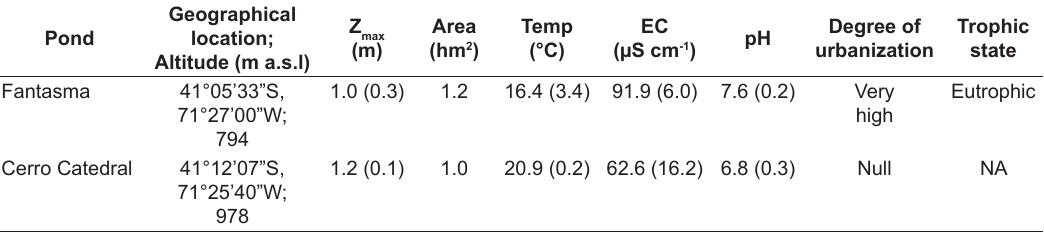
Table 1. Geographical location, morphometric and limnological parameters of the studied ponds (Northwestern Patagonia, Argentina). References: Z : Maximum depth; Temp: Water temperature; EC: Electrical conductivity; max NA: Not available. Data are shown as mean (standard deviation).